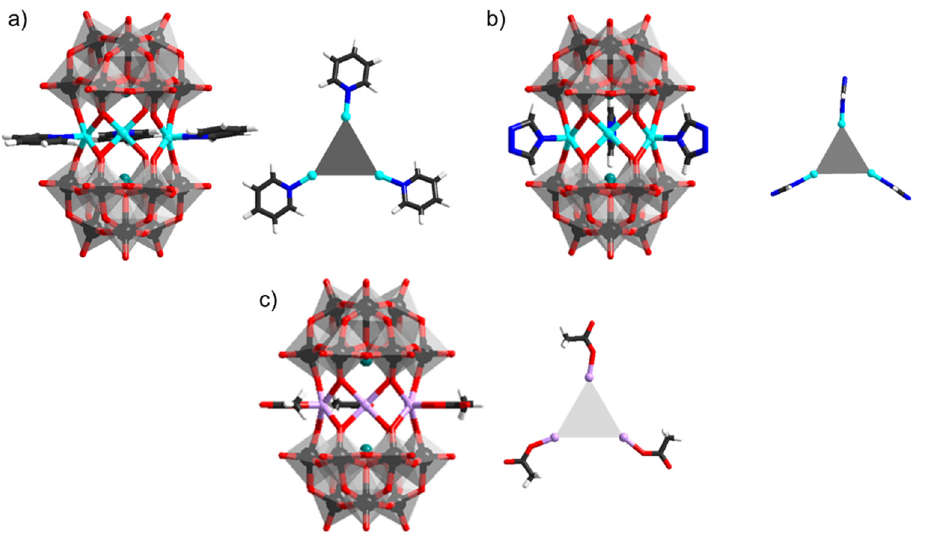
Figure 8. Polyanions and their heterometallic cores: ( a ) [(Ni(py)) 3 (AsW 9 O 33 ) 2 ] 12 − ; ( b ) [(M(Htaz)) 3 (AsW 9 O 33 ) 2 ] 9 − ; ( c ) [(Mn(COOH)) 3 (AsW 9 O 33 ) 2 ] 15 − . Color code: As = green, Ni = cyan, Mn = light pink, H = white frame, C = dark gray frame, {WO 6 } = gray octahedra, W = black, and O = red.